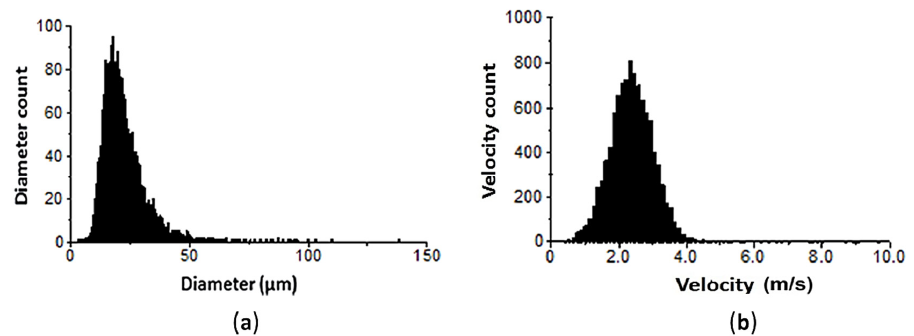
Figure 6. Diameter ( a ) and velocity ( b ) histograms at P w = 4 bar, R = 0 mm.